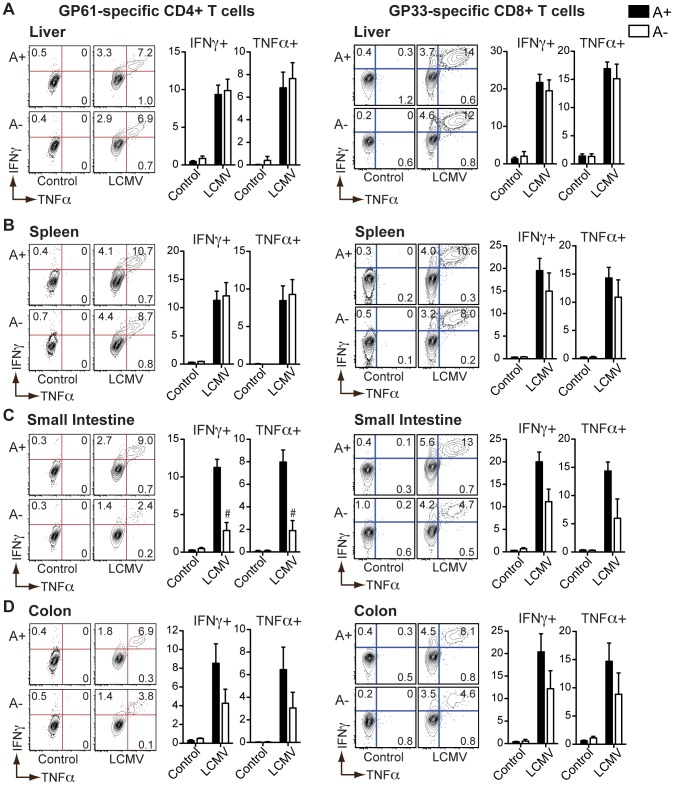
LCMV-specific TH1 responses in the intestinal mucosa are dependent on vitamin A metabolites.Flow cytometric analysis of intracellular cytokines expressed by cells harvested from the liver (A), spleen (B), small intestine (C), or colon (D) of LCMV-infected mice following a 5-hour stimulation with GP61 or GP33 peptides (10 µg/mL) in the presence of brefeldin A. Representative contour plots are gated on live CD4+ or CD8+ T cells. n = 3–5 mice per group. Error bars illustrate SEM; #p<0.001. Results are representative of three independent experiments.